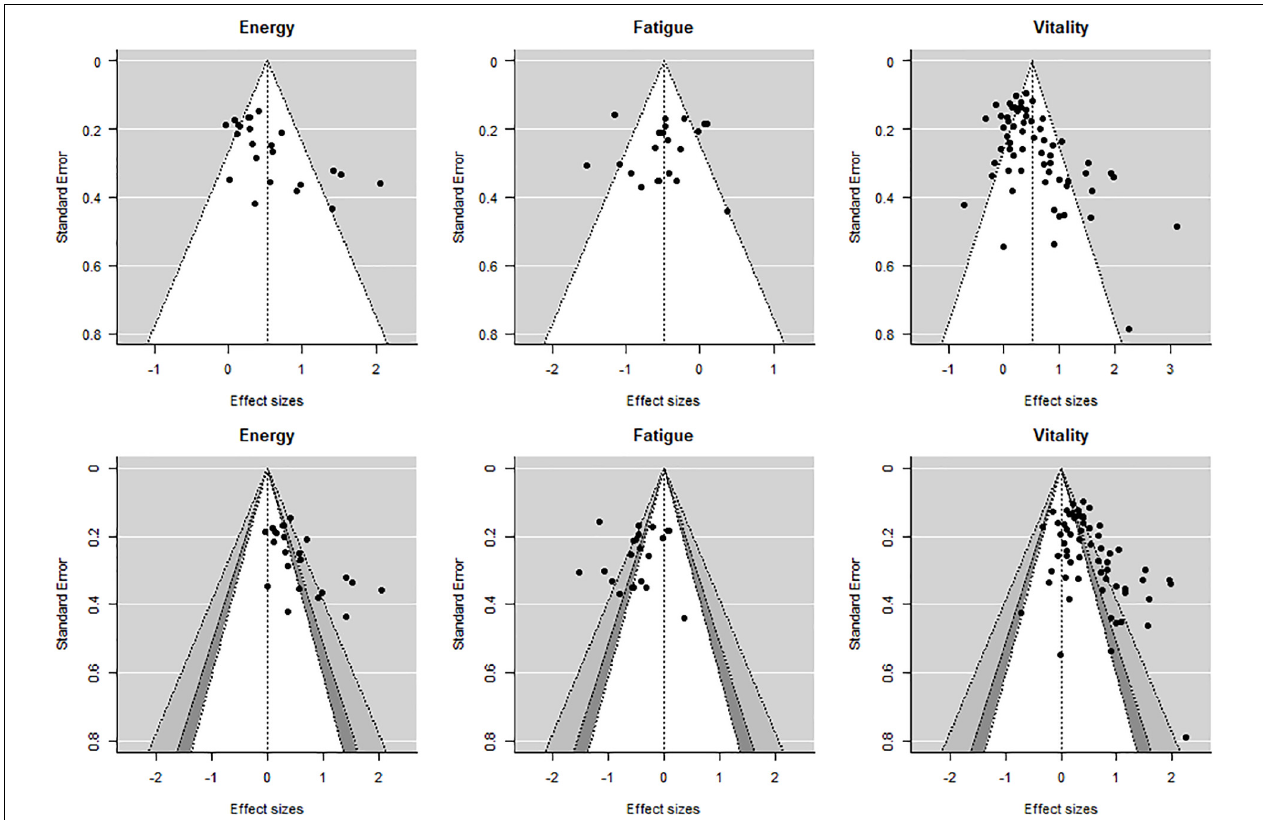
FIGURE 6 | Normal and contour enhanced funnel plots. Aggregated effects (one per study per outcome). Shading for the bottom row: white: 0.10 < p < 1.00, dark gray: 0.05 < p < 0.10, medium gray: 0.01 < p < 0.05, and lightest gray: 0.00 < p < 0.01.